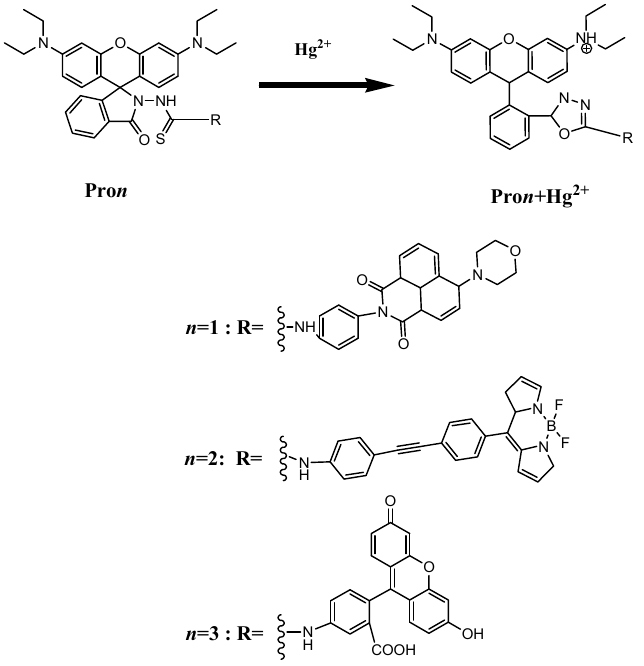
Figure 1. Molecular structures of Pro1, Pro1+Hg 2+ , Pro2, Pro2+Hg 2+ , Pro3 and Pro3+Hg 2+ .